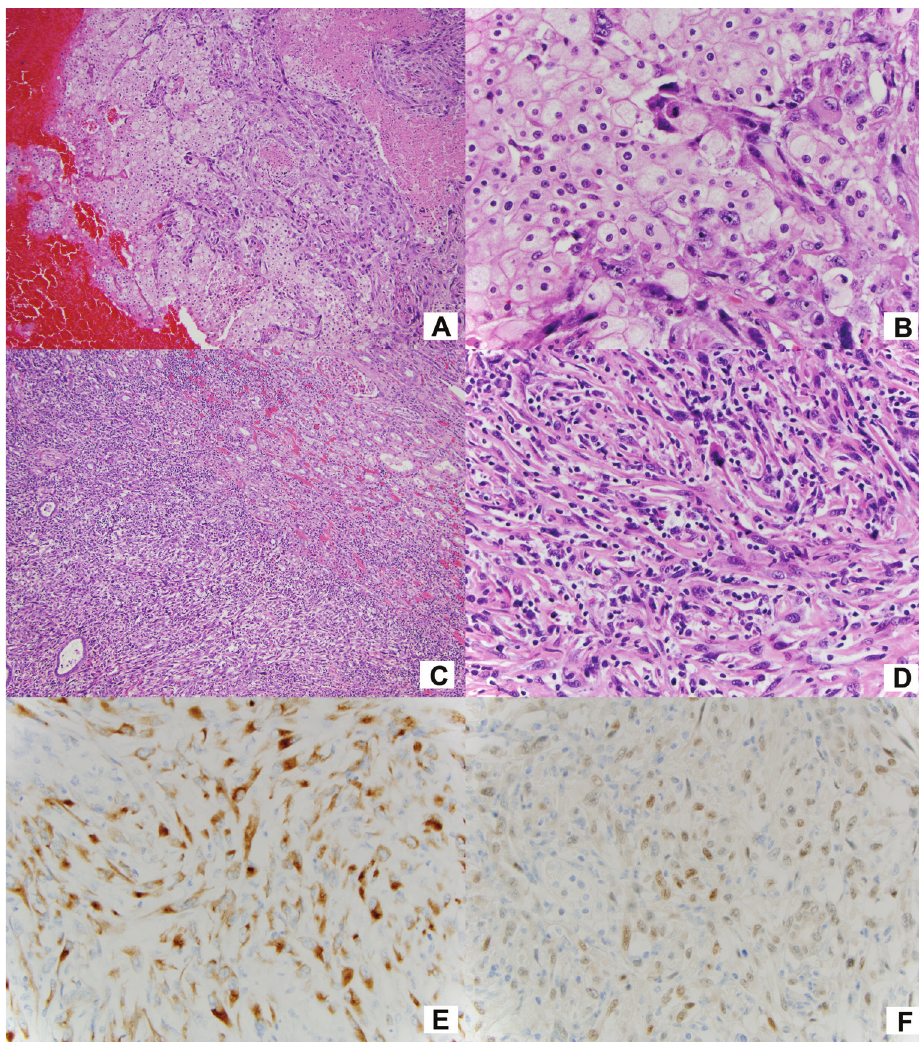
Figure 1. (A) Chromophobe carcinoma mixed with sarcomatoid carcinoma, (B) high power of (A), (C) pure sarcomatoid carci- noma invading the renal parenchyma, (D) high power of the sarcomatoid carcinoma, (E) positive CAM 5.2 (keratin) staining, and (F) positive PAX8